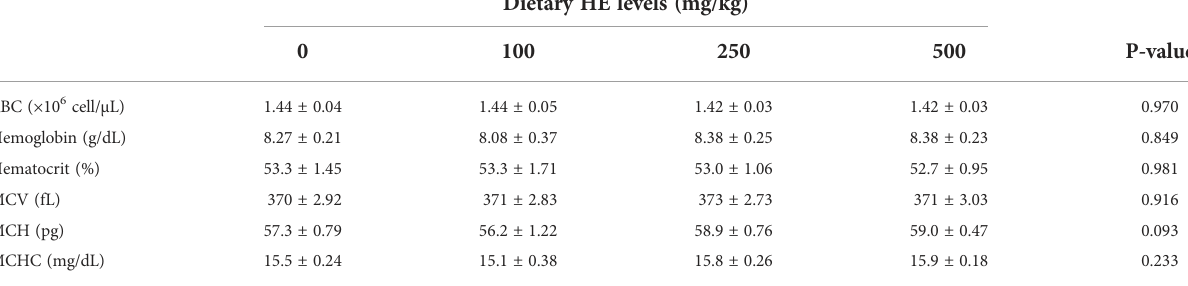
TABLE 5 Hematological parameters of rainbow trout fed diets supplemented with 0-500 mg/kg HE over eight weeks (mean ± SE; n =